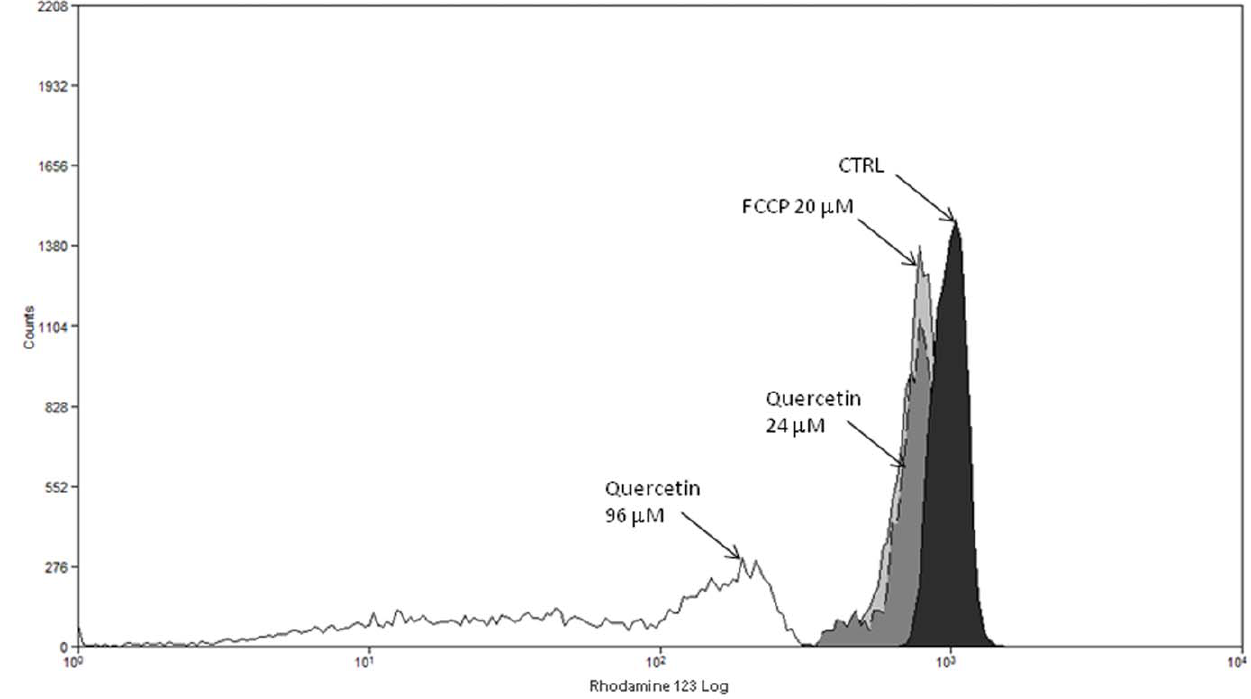
Figure 2. Flow cytometry analysis of Leishmaniaamazonensis treated with quercetin. Leishmania amazonensis was cultivated in Schneider’s Drosophila medium at 26 u C as for 48 h, in the absence or in the presence of 24 m M and 96 m M quercetin. Promastigotes were subsequently labeled with rhodamine 123 (10 m g/ml). Data acquisition and analysis were performed using a FACSCalibur flow cytometer (equipped with the Cell Quest software). A total of 10,000 events were acquired in the regions previously established as those corresponding to each form of L. amazonensis . Positive control was obtained by addition of FCCP (20 m M) for 20 minutes. In the control (absence of quercetin) the same volume of vehicle (DMSO 0.2%) was added to the growth medium.